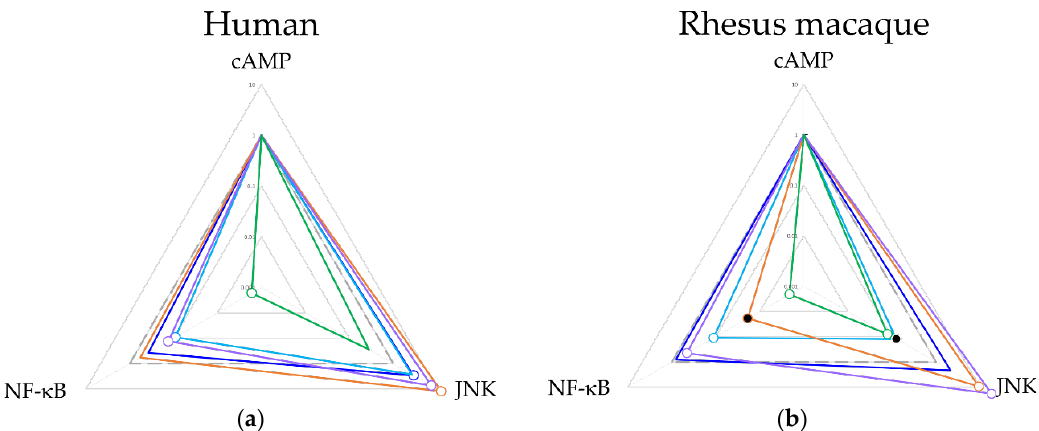
Figure 4. Web chart reflecting the calculated bias factor from ∆∆ log( τ ( a ) and rhesus macaque ( b ). Empty circles represent p < 0.05 on ∆ log( τ the test ligand and the reference ligand DAMGO. Closed circles represent p < 0.05 on ∆ log( τ values comparisons between human and rhesus macaque. Morphine (blue), met-enkephalin (cyan), endomorphin-1 (orange), β -endorphin (purple), TRV130 (green).